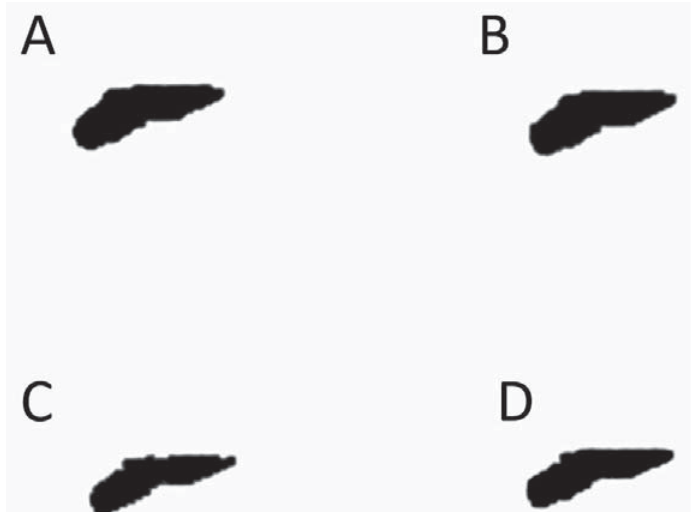
Figure 3- (cid:3)(cid:36)(cid:91)(cid:76)(cid:68)(cid:79)(cid:3)(cid:86)(cid:79)(cid:76)(cid:70)(cid:72)(cid:86)(cid:3)(cid:82)(cid:73)(cid:3)(cid:87)(cid:75)(cid:72)(cid:3)(cid:88)(cid:81)(cid:191)(cid:79)(cid:79)(cid:72)(cid:71)(cid:3)(cid:70)(cid:68)(cid:89)(cid:76)(cid:87)(cid:92)(cid:3)(cid:82)(cid:73)(cid:3)(cid:85)(cid:82)(cid:82)(cid:87)(cid:3)(cid:70)(cid:68)(cid:81)(cid:68)(cid:79)(cid:3)(cid:82)(cid:69)(cid:87)(cid:68)(cid:76)(cid:81)(cid:72)(cid:71)(cid:3)(cid:69)(cid:92)(cid:3)(cid:71)(cid:76)(cid:73)(cid:73)(cid:72)(cid:85)(cid:72)(cid:81)(cid:87)(cid:3)(cid:86)(cid:72)(cid:74)(cid:80)(cid:72)(cid:81)(cid:87)(cid:68)(cid:87)(cid:76)(cid:82)(cid:81)(cid:3)(cid:80)(cid:72)(cid:87)(cid:75)(cid:82)(cid:71)(cid:86)(cid:17)(cid:3)(cid:36)(cid:29)(cid:3)(cid:68)(cid:88)(cid:87)(cid:82)(cid:80)(cid:68)(cid:87)(cid:76)(cid:70)(cid:3)(cid:80)(cid:72)(cid:87)(cid:75)(cid:82)(cid:71)(cid:30)(cid:3)(cid:37)(cid:29)(cid:3)(cid:89)(cid:76)(cid:86)(cid:88)(cid:68)(cid:79)(cid:3) (cid:80)(cid:72)(cid:87)(cid:75)(cid:82)(cid:71)(cid:3)(cid:177)(cid:3)(cid:40)(cid:91)(cid:68)(cid:80)(cid:76)(cid:81)(cid:72)(cid:85)(cid:3)(cid:6)(cid:3)(cid:20)(cid:30)(cid:3)(cid:38)(cid:29)(cid:3)(cid:89)(cid:76)(cid:86)(cid:88)(cid:68)(cid:79)(cid:3)(cid:80)(cid:72)(cid:87)(cid:75)(cid:82)(cid:71)(cid:3)(cid:177)(cid:3)(cid:40)(cid:91)(cid:68)(cid:80)(cid:76)(cid:81)(cid:72)(cid:85)(cid:3)(cid:6)(cid:3)(cid:21)(cid:30)(cid:3)(cid:39)(cid:29)(cid:3)(cid:89)(cid:76)(cid:86)(cid:88)(cid:68)(cid:79)(cid:3)(cid:80)(cid:72)(cid:87)(cid:75)(cid:82)(cid:71)(cid:3)(cid:177)(cid:3)(cid:40)(cid:91)(cid:68)(cid:80)(cid:76)(cid:81)(cid:72)(cid:85)(cid:3)(cid:6)(cid:3)(cid:22)